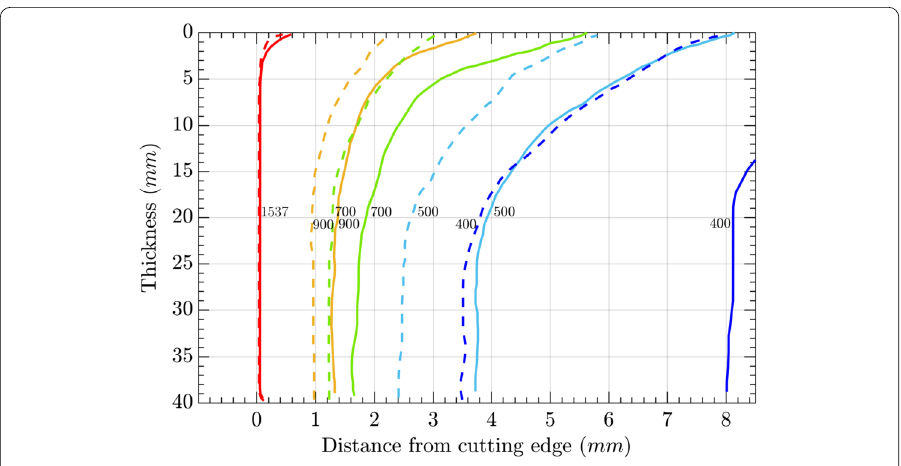
Figure 2 Isothermal lines in the plane transversal to the cutting direction. Case 135 mm/min (solid) and case 270 mm/min